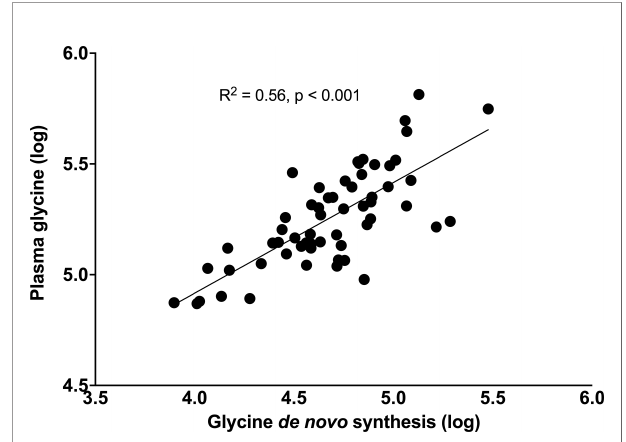
FIGURE 4 | Relationship between plasma glycine concentrations with rates of glycine de novo synthesis. Data were log-transformed, and their association tested using the linear regression